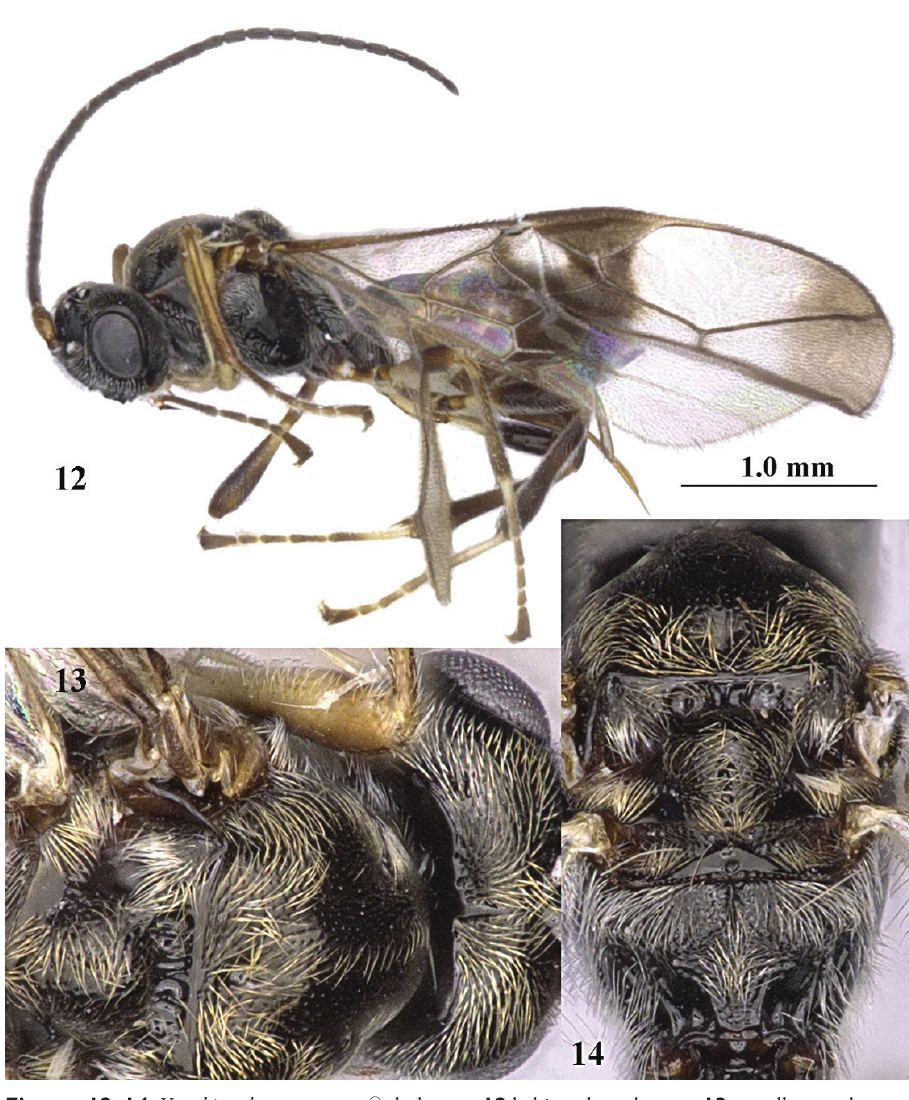
Figures 12–14. Xynobius chrysops sp. n., ♀ , holotype. 12 habitus, lateral aspect 13 scutellum and poste- rior half of mesoscutum, dorsal aspect 14 metanotum and propodeum, dorsal